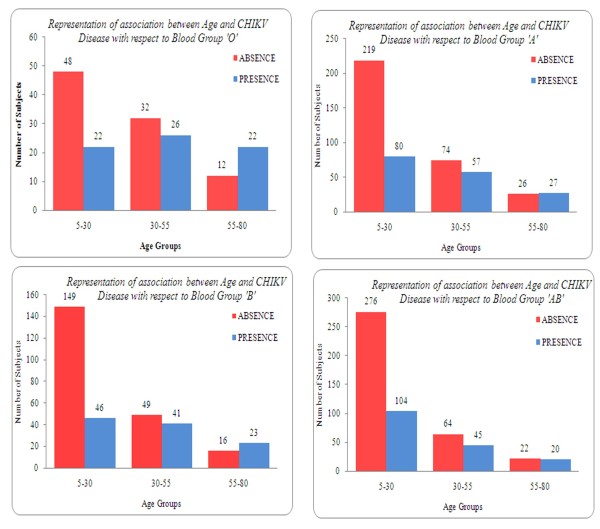
Representation of association between Age group and CHIK disease.